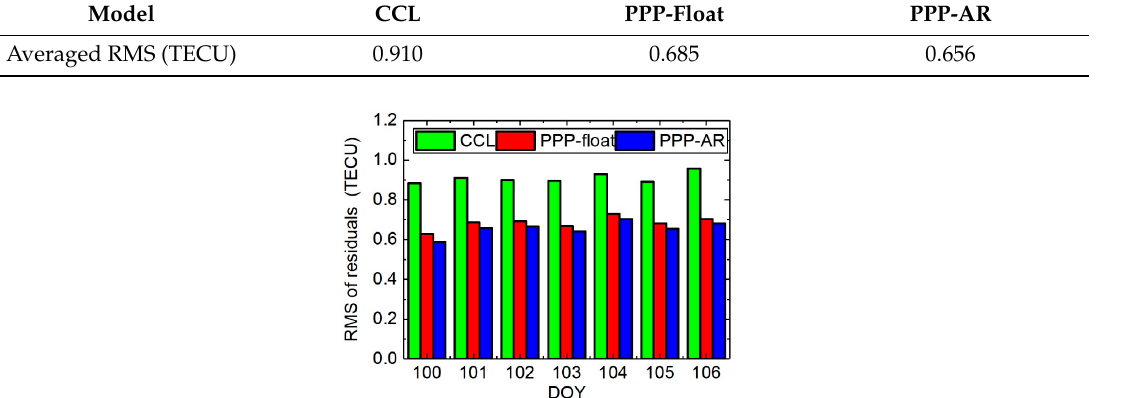
Figure 7. RMS of posteriori residuals for the CCL, PPP-float, and PPP-AR ionospheric observables from DOY 100 to 106, 2017.